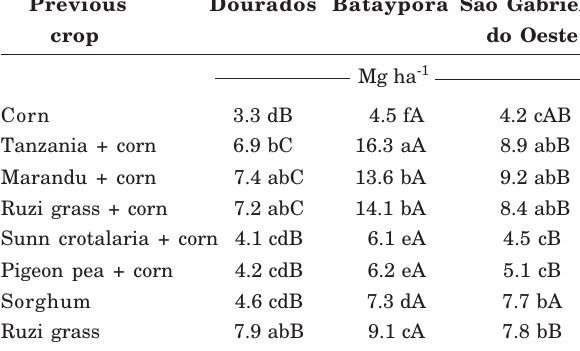
Means followed by the same lowercase letter in a column, and by the same uppercase letter in a row are not significantly different by the Tukey test (p 0.05).